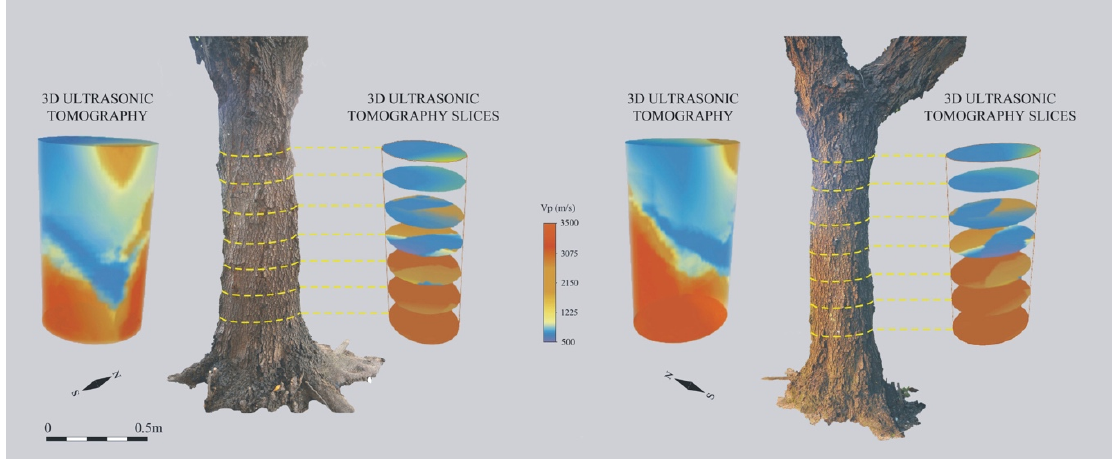
Figure 12. ( a ) Visual inspection; ( b ) CRP 3D model of the stem reflectivity; ( c ) 3D ultrasonic tomography.